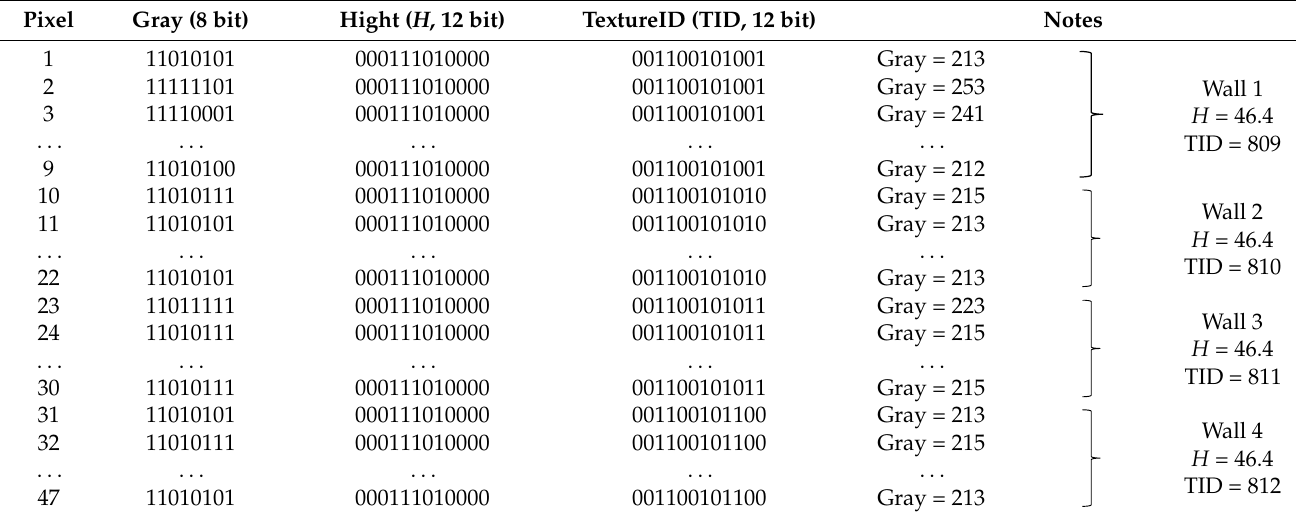
Table 3. The building façade texture superpixel data in Figure 7b.